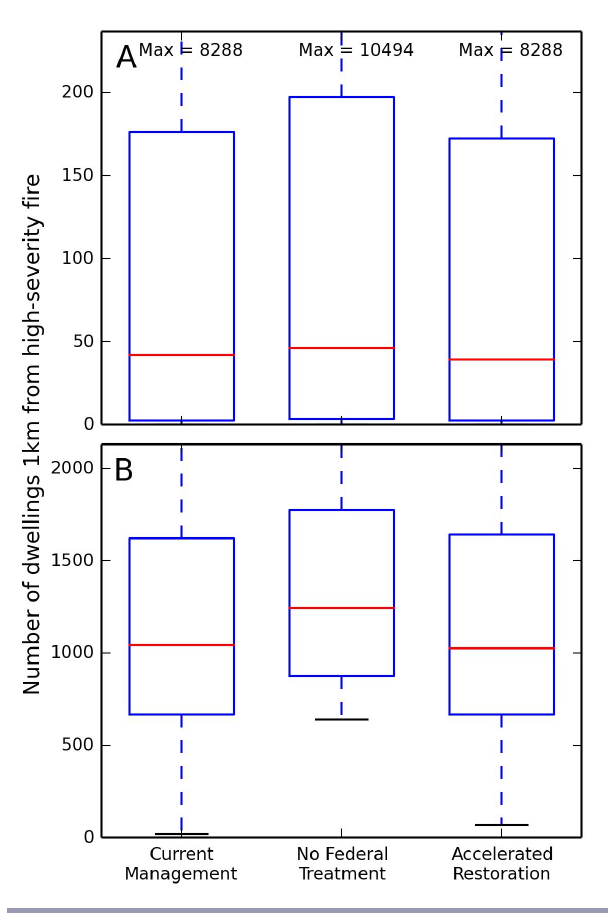
Fig. 5. Box and whisker plots of number of dwellings exposed to high-severity fire for different management scenarios. Annual number of dwellings in all fire years (A), and the top 10% of fire years ( N = 75 of 750 replication years) in terms of area (B).